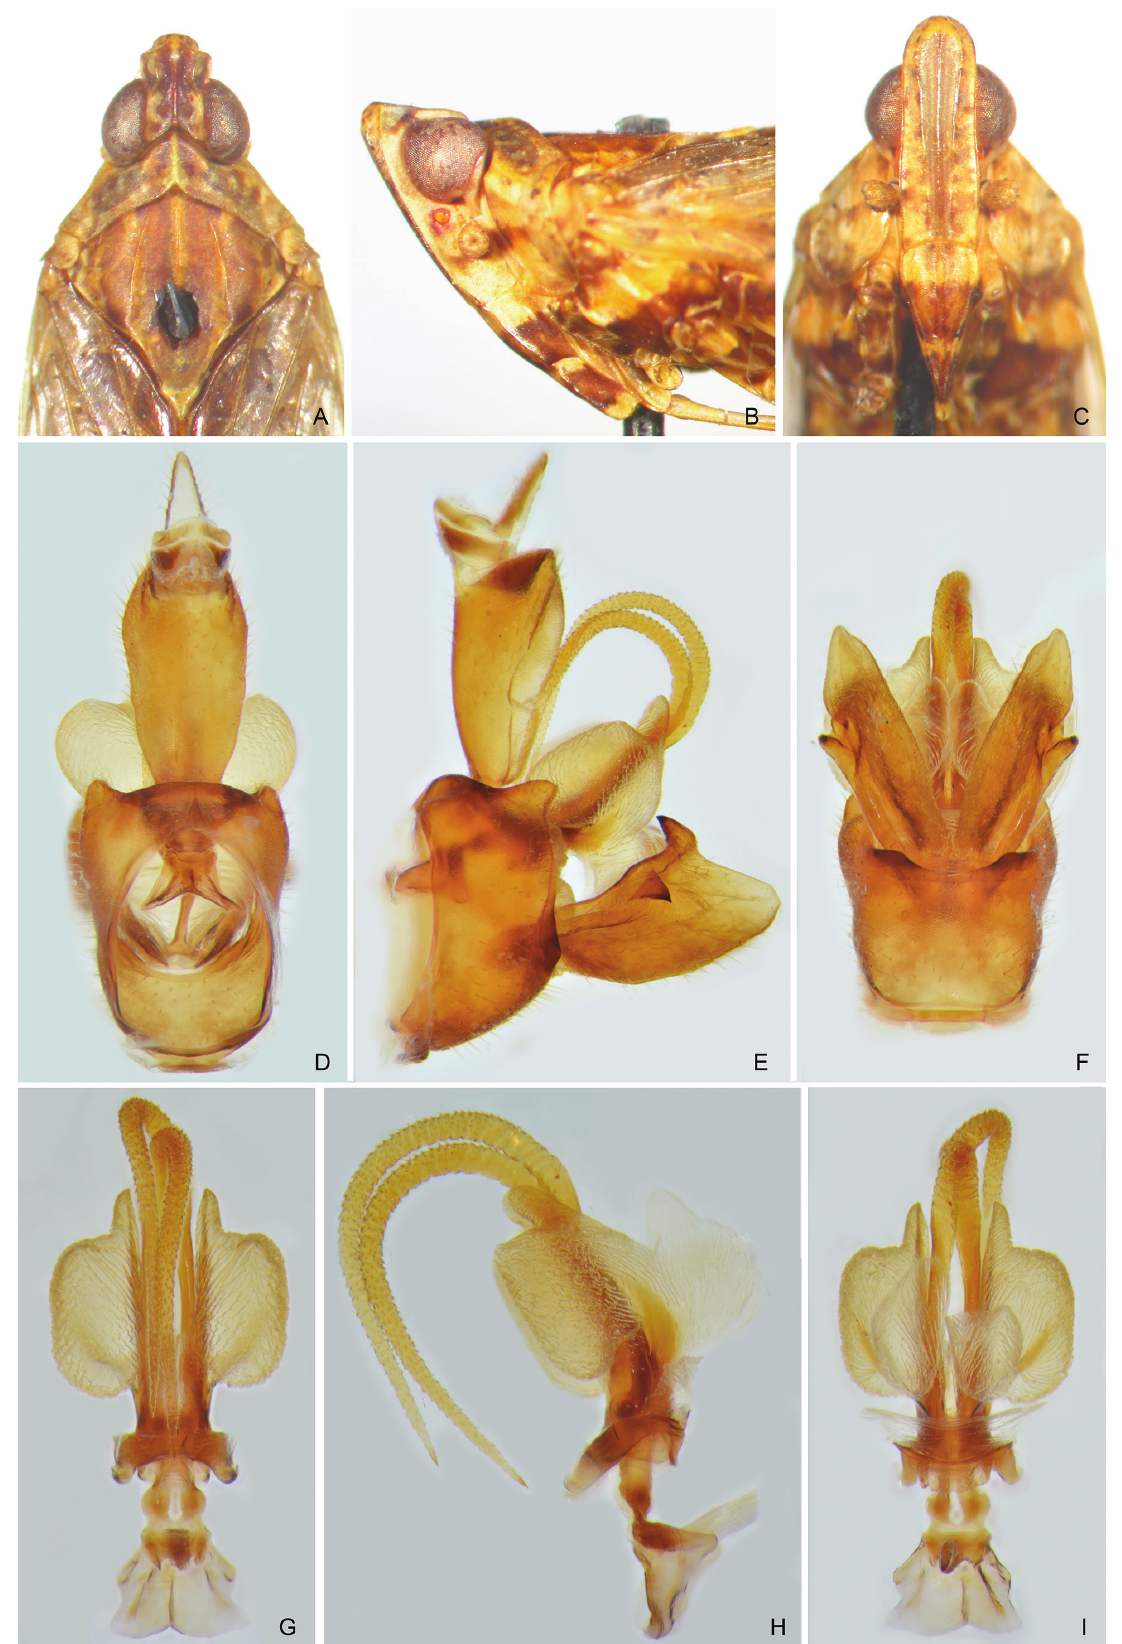
Figure 10. Orthopagus splendens (Germar). ( A ) Head, pronotum and mesonotum, dorsal view. ( B ) Head and pronotum, lateral view. ( C ) Head and pronotum, ventral view. ( D ) Male segment X and pygofer, dorsal view. ( E ) Male pygofer, gonostyles, and segment X, lateral view. ( F ) Male pygofer and gonostyles, ventral view. ( G ) Aedeagus, dorsal view. ( H ) Aedeagus, lateral view. ( I ) Aedeagus, ventral